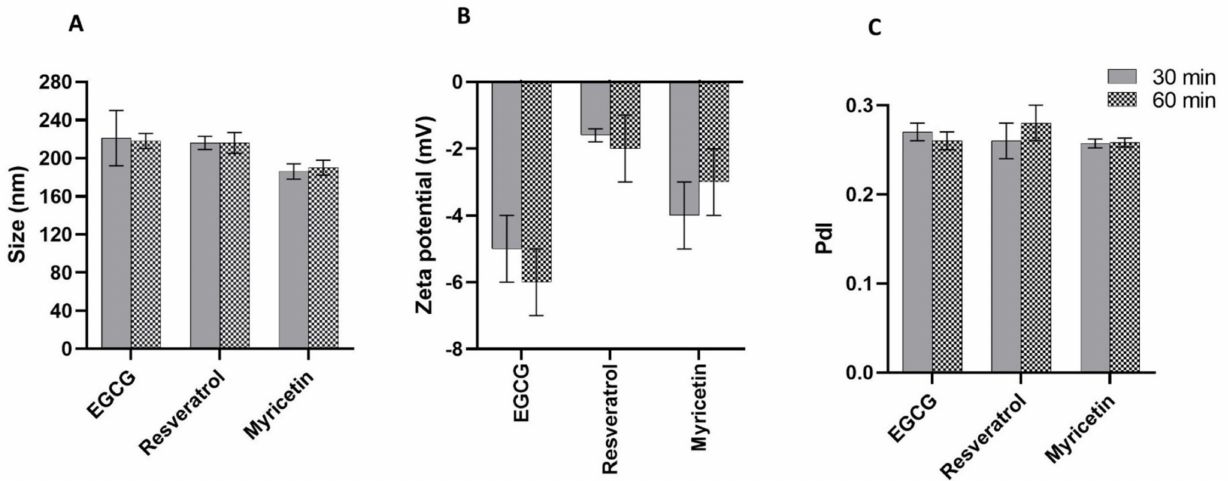
Figure 4. Mean particle size ( A ), zeta potential (ZP) ( B ) and polydispersity index (PdI) ( C ), of the EGCG, resveratrol and myricetin-loaded SLNs after the accelerated stability assay (mean ± SD, n =